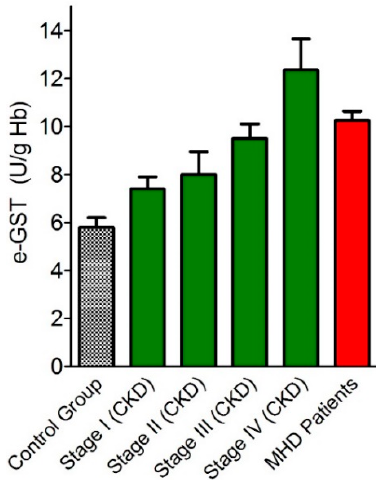
Figure 6. Erythrocyte glutathione transferase (e-GST) levels in healthy volunteers, chronic kidney disease patients and hemodialysis patients. Control group (healthy subjects), chronic kidney disease (CKD) stages I–IV (green bars); maintenance hemodialysis (MHD) patients (red bar) (modified from Reference [38]).